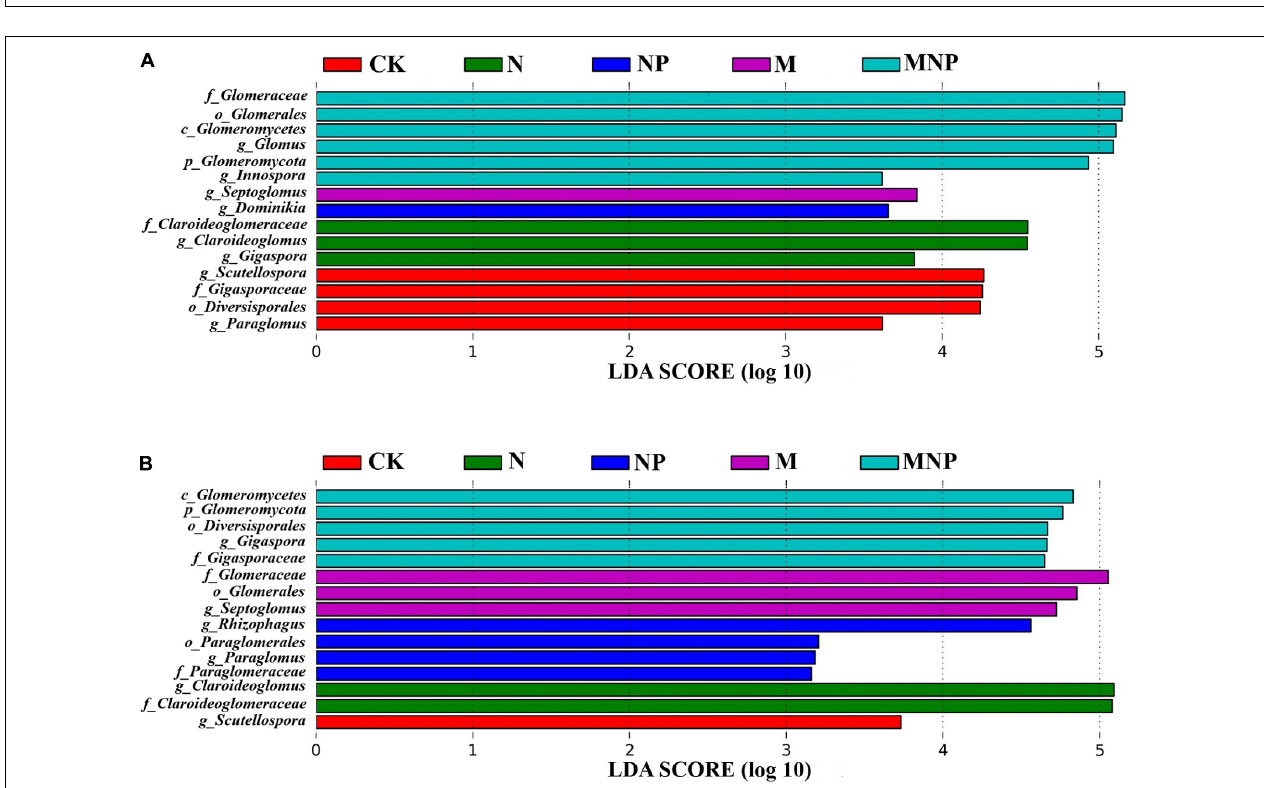
FIGURE 5 | The LDA (linear discriminant analysis) distribution histogram of biomarkers in the soil (A) and roots (B) under different fertilization treatments. Only taxa with LDA values greater than 3.0 ( p < 0.05) are shown.